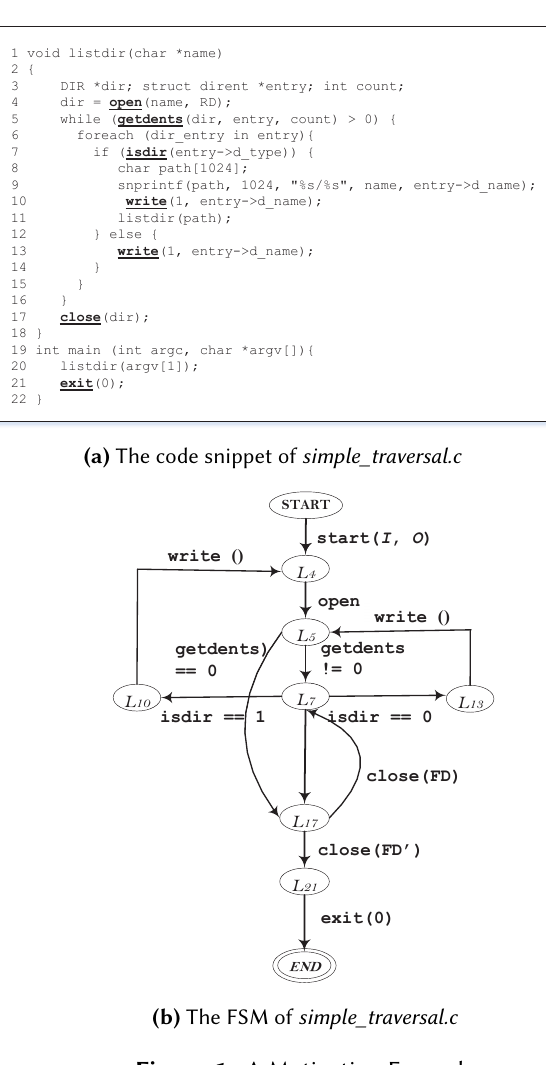
Figure 1. A Motivating